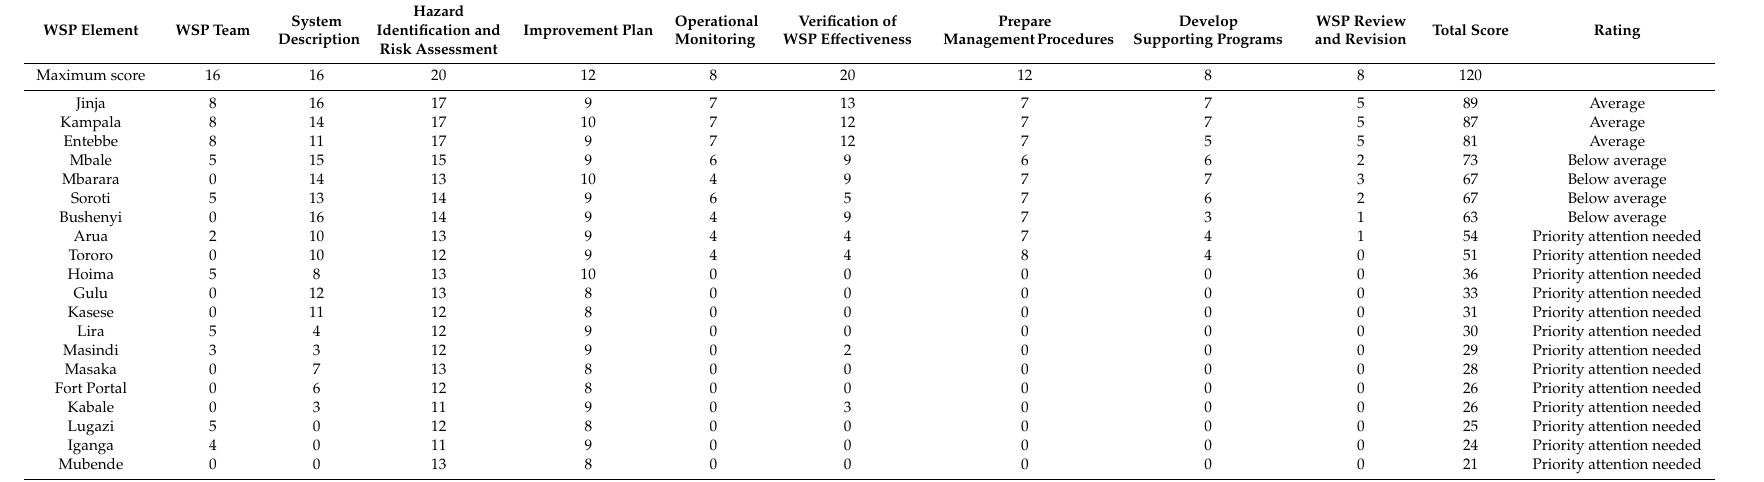
Table 2. Summary informal WSP audit results for the 20